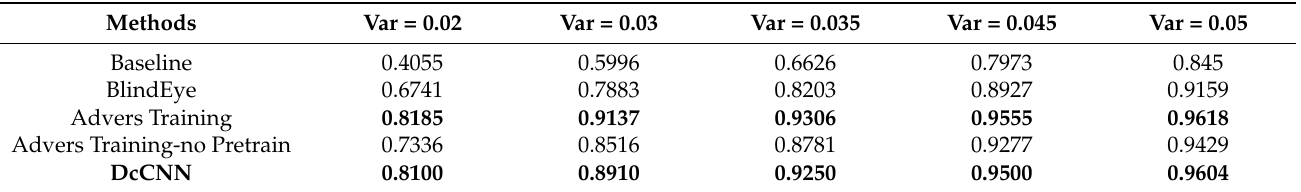
Table 4. Comparison of accuracies for color-biased MNIST dataset for different values of variances among existing methods. Results are calculated on the testing